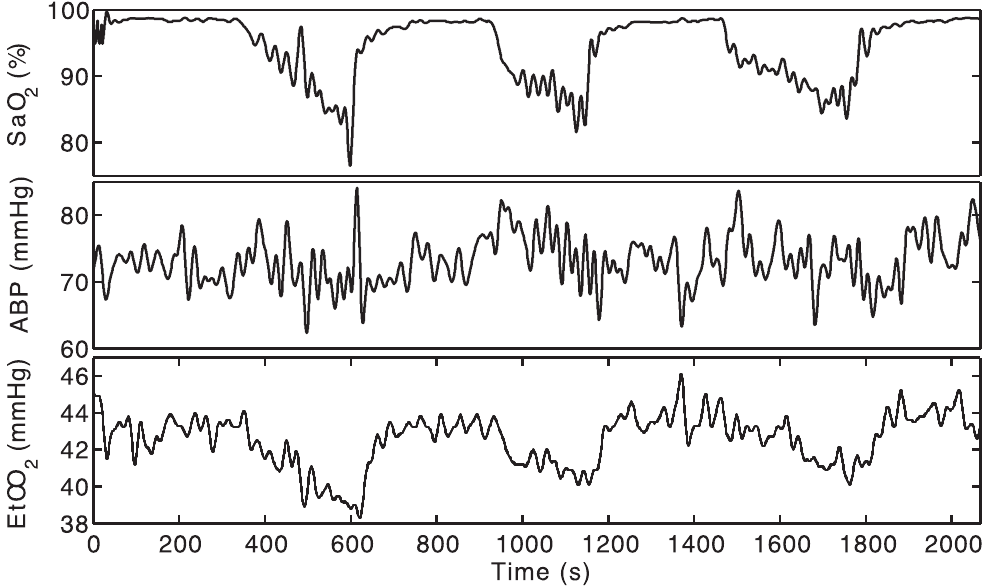
Figure 1. Typical input traces. SaO 2 (%, top panel), mean ABP (mmHg, middle panel) and EtCO 2 (mmHg, bottom panel) for a typical subject (Subject 6) following the resampling and filtering described in the text. Each experiment lasted 30–40 minutes in total.